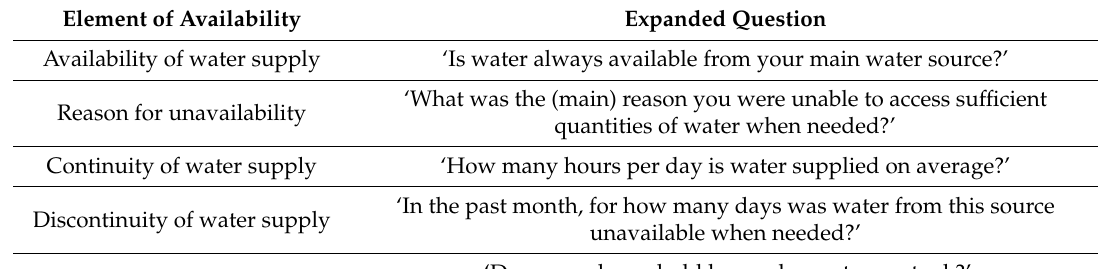
Table A1. The JMP’s Expanded Questions on Water